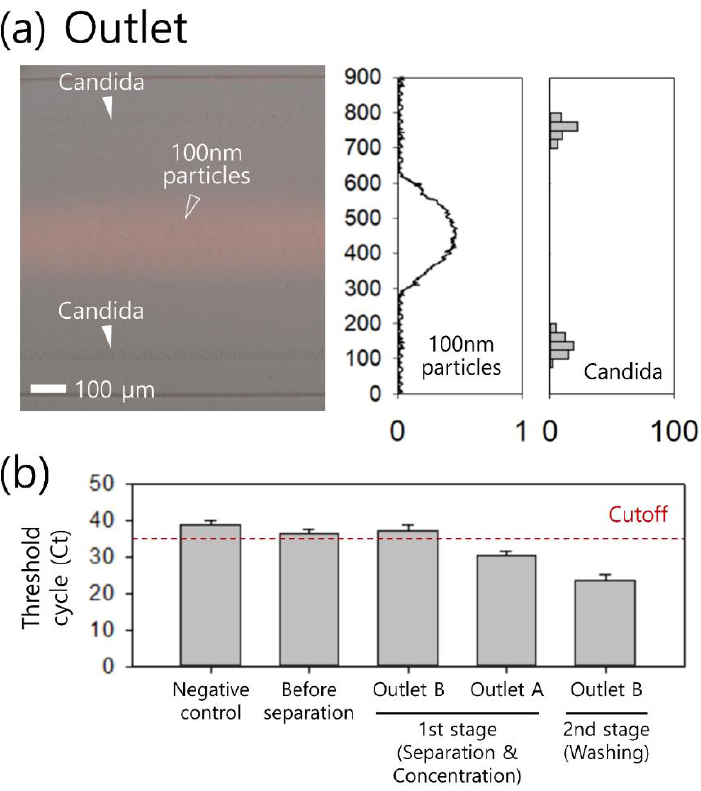
Figure 5. ( a ) Continuous purification of concentrated candida cells using a viscoelastic co-flow system. Stacked fluorescent microscopic images ( left ) and distribution of candida cells and 100 nm particles ( right ) at the outlet region. ( b ) The Ct values for the negative control (Ct = 38.6) represent the 0.1% ( w / v ) HA buffer solution. Before the separation process, candida cells could hardly be detected due to a large number of contaminants, including blood cells (Ct = 36.5). After the first-step separation, the Ct values for outlets A and B were 30.3 and 37.2, respectively. After the second-step washing process, the Ct value was measured to be 23.6. The dashed red line at Ct = 35 indicates the cutoff value for real-time PCR analysis. The error bars show the standard deviation from repeated measurements (n = 5).